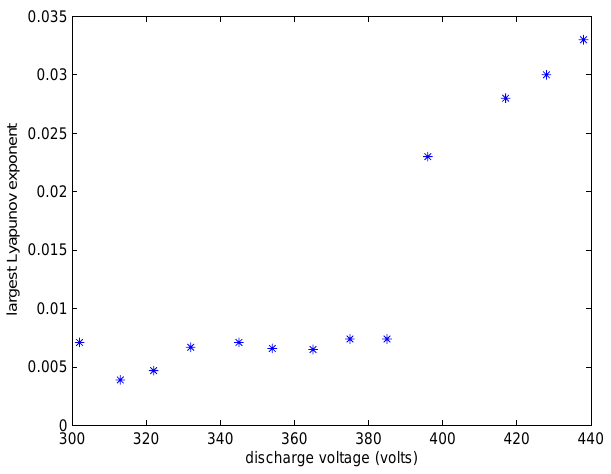
Fig. 3. Largest Lyapunov exponent shows a clear jump when the floating potential fluctuations exhibiting a transition from quasi pe- riodic to chaos.